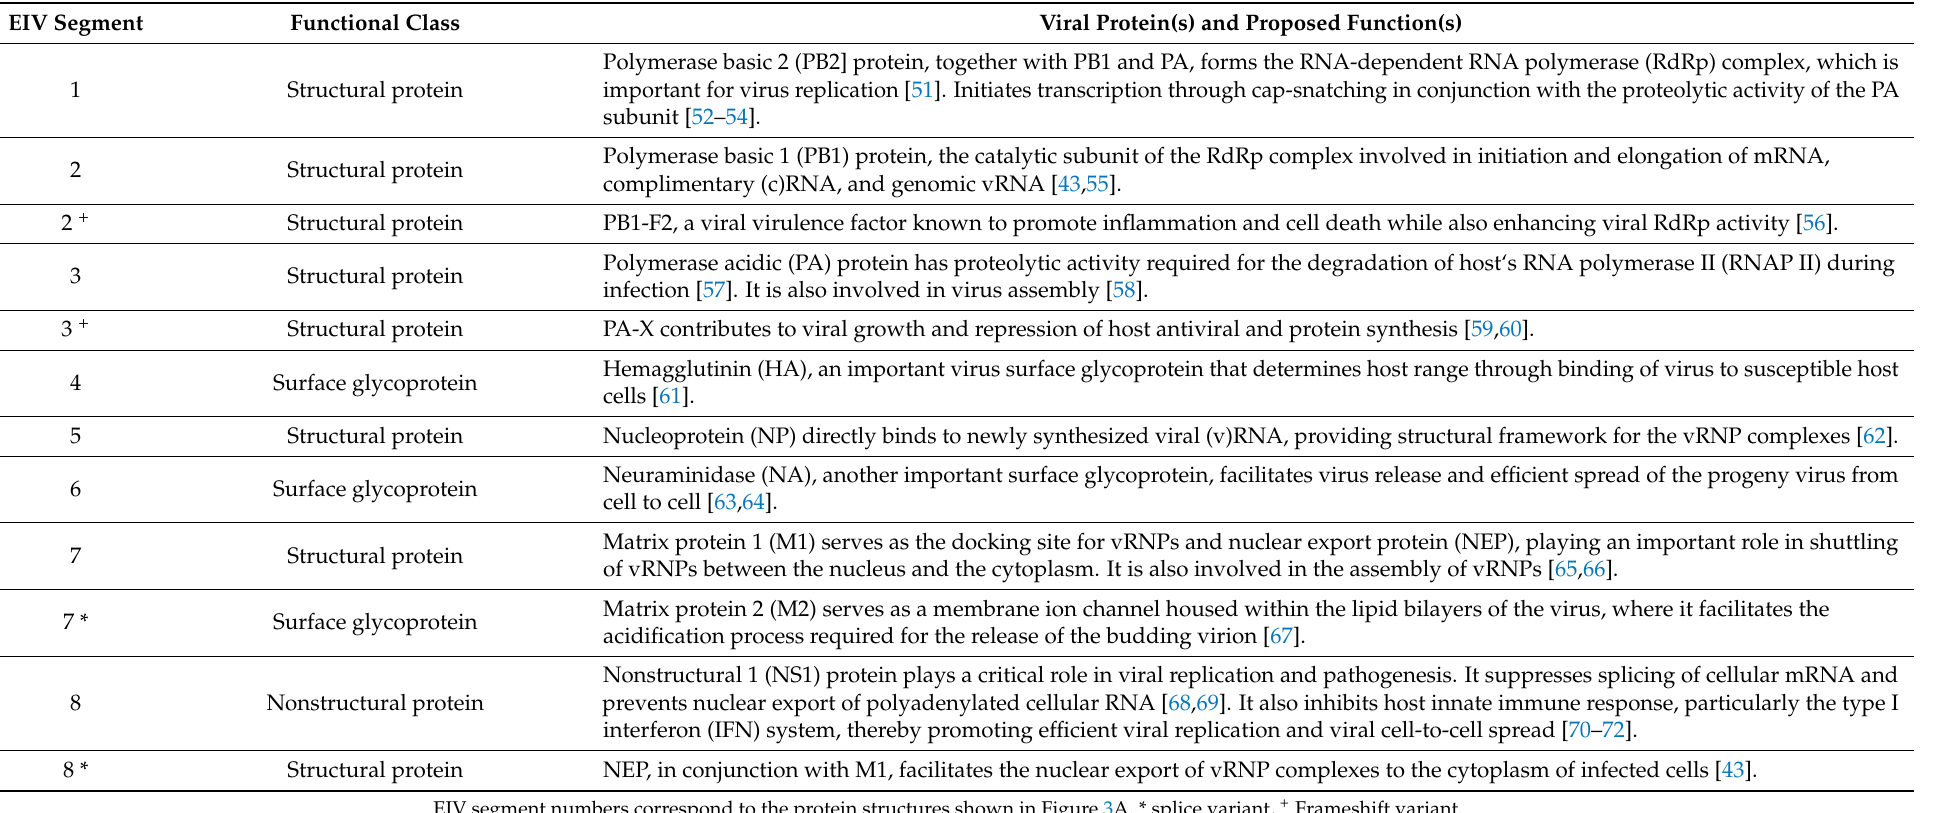
Table 2. EIV segments and their